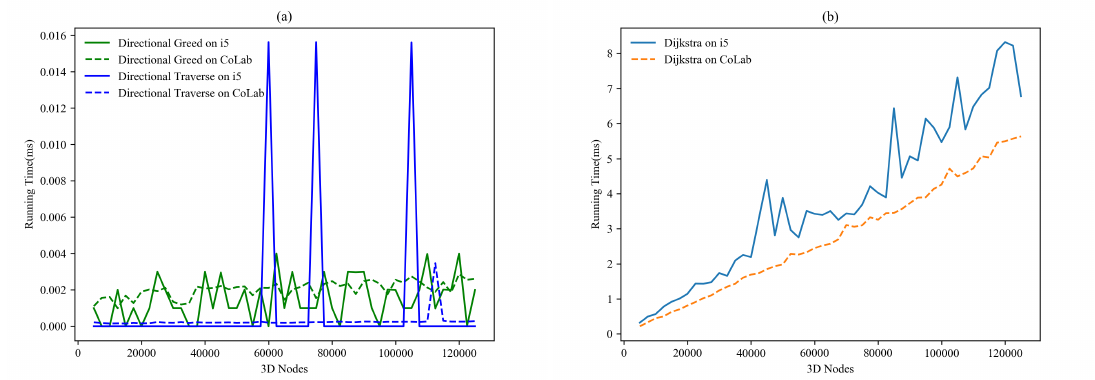
Figure 15. Running time of 3D pathfinding algorithms on i5 and